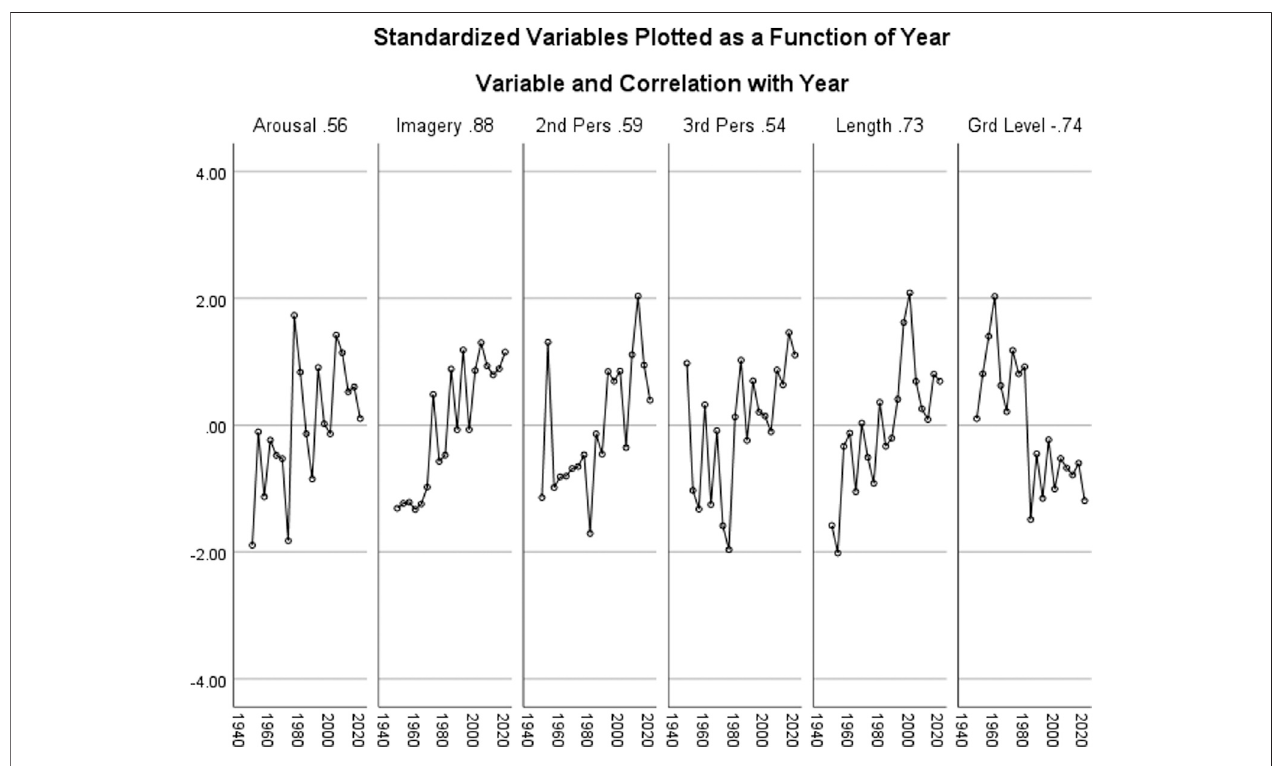
FIGURE 1 | Changes across time for six standardized variables signi fi cantly related to year.